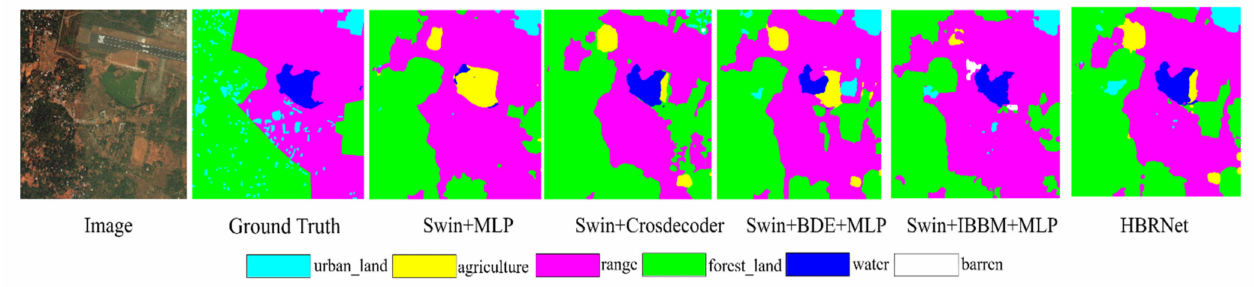
Figure 16. Visualization of the results on the DeepGlobe dataset after adding different modules on